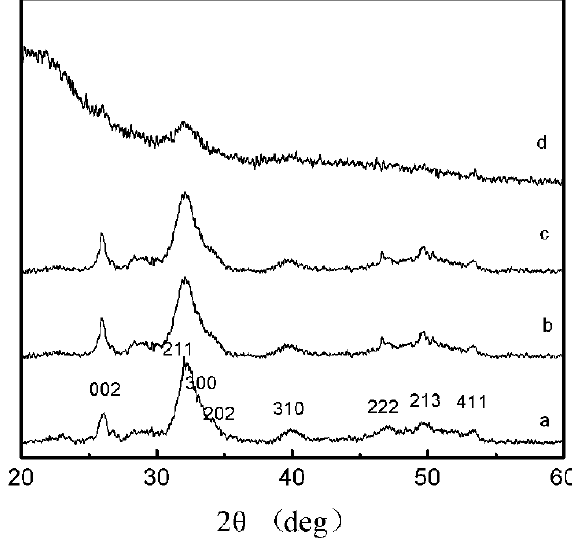
, ( c ) HAP-5, and ( d ) 2